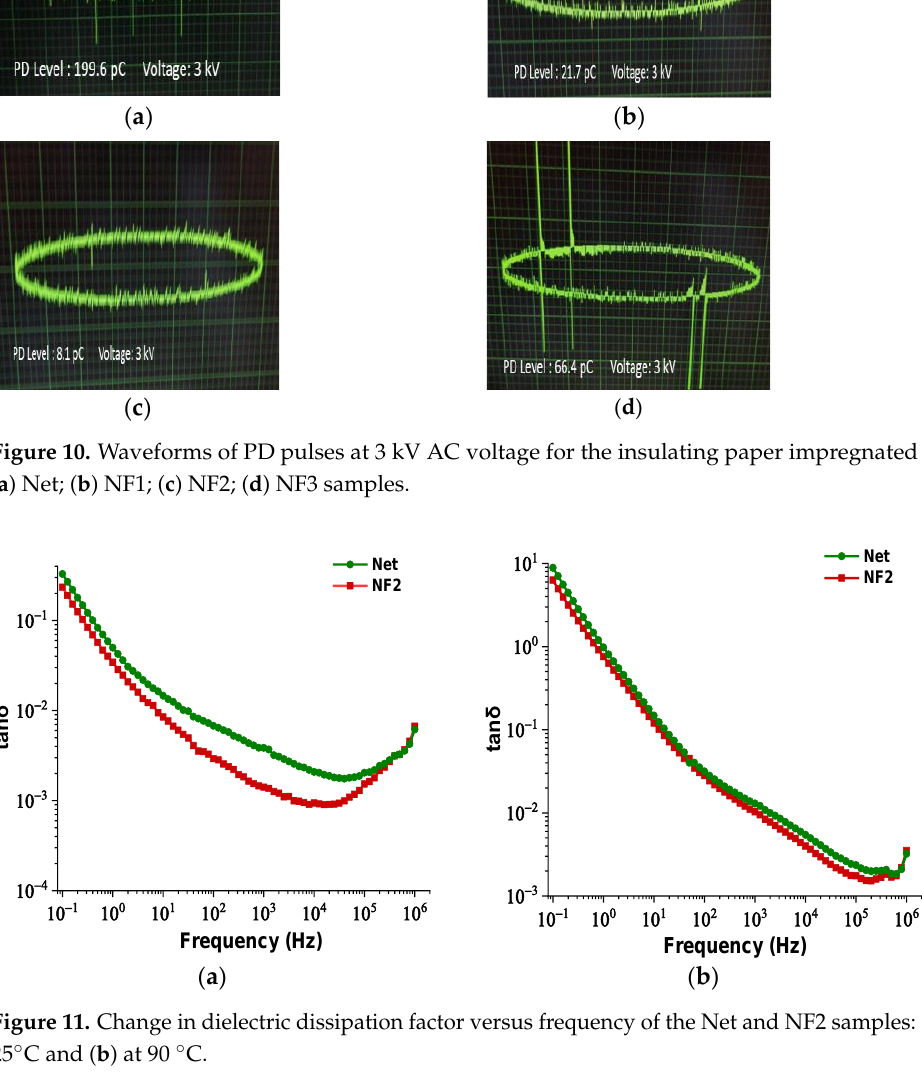
Figure 11. Change in dielectric dissipation factor versus frequency of the Net and NF2 samples: ( a ) at 25°C and ( b ) at 90 °C.